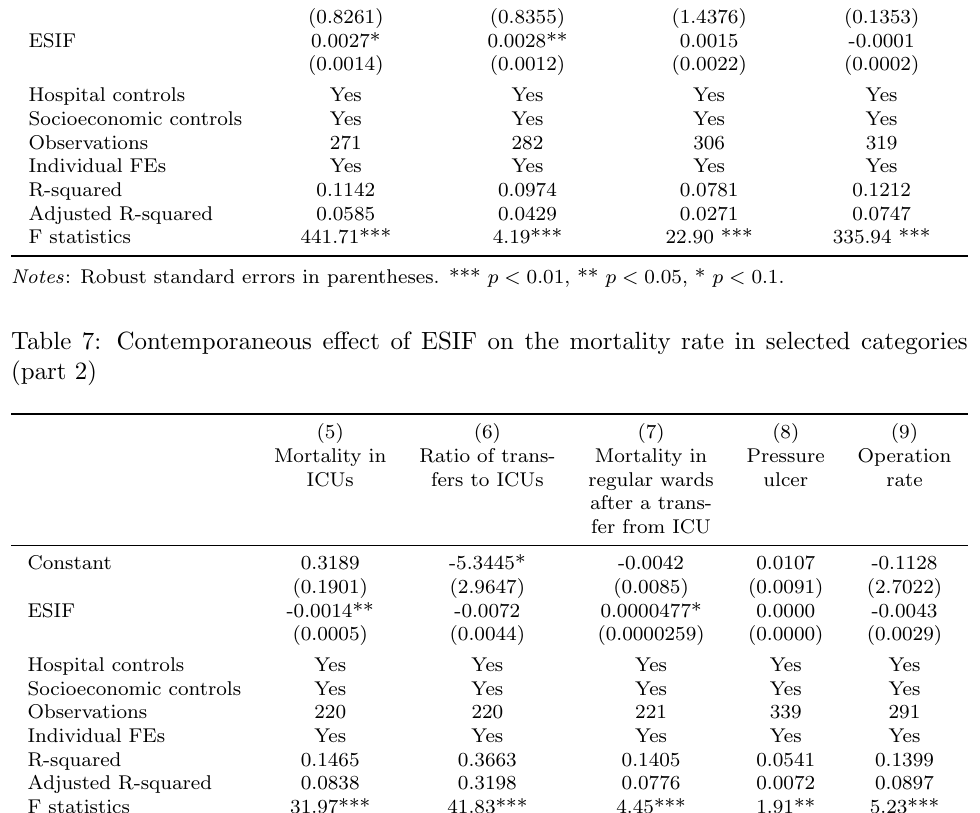
Table 6: Contemporaneous effect of ESIF on the mortality rate in selected categories (part 1) (1) (2) (3) (4) Mortality after Mortality caused Mortality after Mortality after femur fracture by myocardial acute stroke interventions (age over 65) infarction after emergency (age 35-74) Constant -1.4762* 0.0512